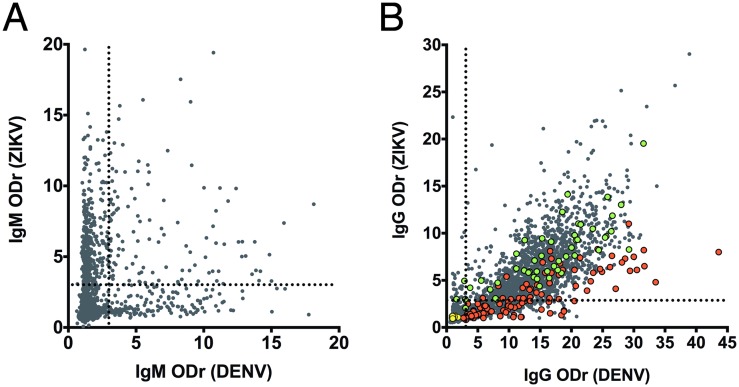
Reactivity of sera against inactivated Dengue and Zika viruses by ELISA.IgM (A) and IgG (B) Optical Density ratio (ODr = OD (target) / OD (noise)) against DENV (abscissa) and ZIKV (ordinate) obtained by ELISA. Values are positive if ODr is ≥ 3 (dotted line) in an ELISA assay using total inactivated virus as target. The IgM group (n = 5,519) is included in the IgG group (n = 5,600). Three groups were assembled: ZIKV-IgM-positive (green, n = 50), flavivirus (red, n = 99), and negative (yellow, n = 50) groups.